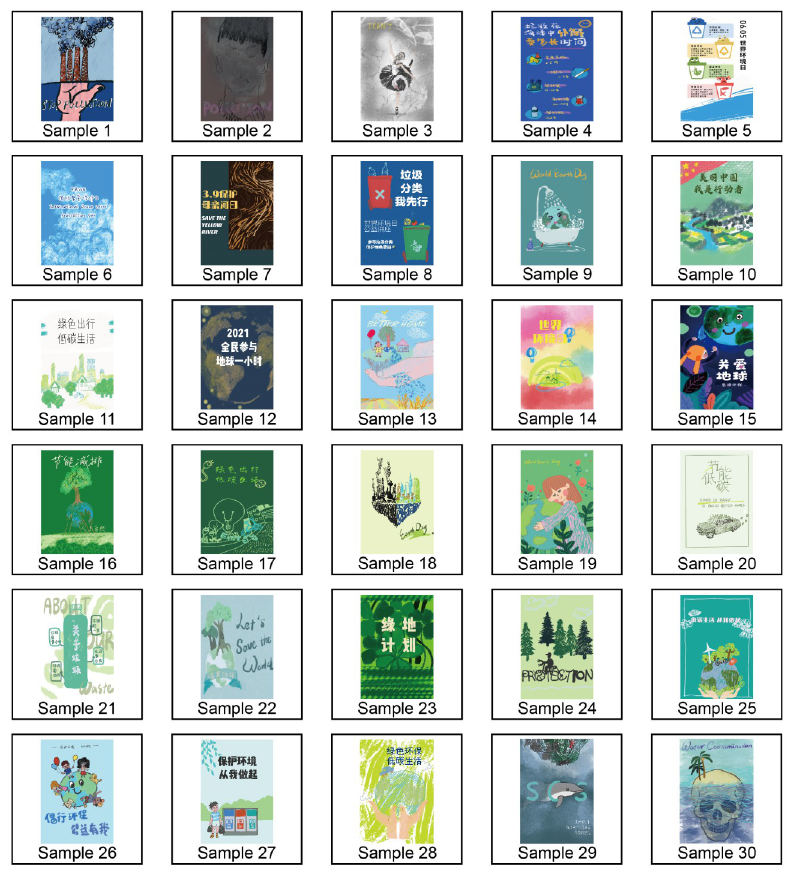
Fig 2. Collection results of EP